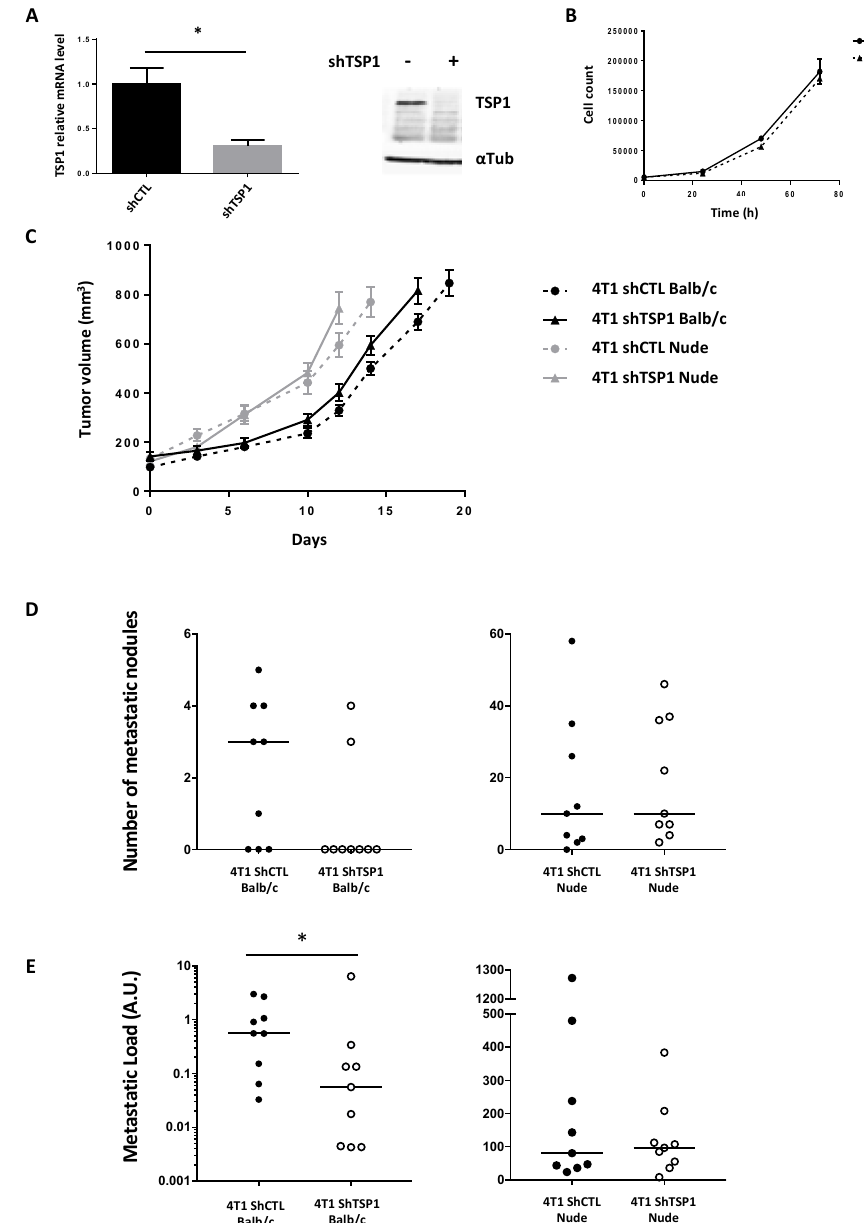
as compared to immunocompetent mice. Strikingly, TSP1 knockdown did not compromise 4T1 lung metastasis in nude mice.